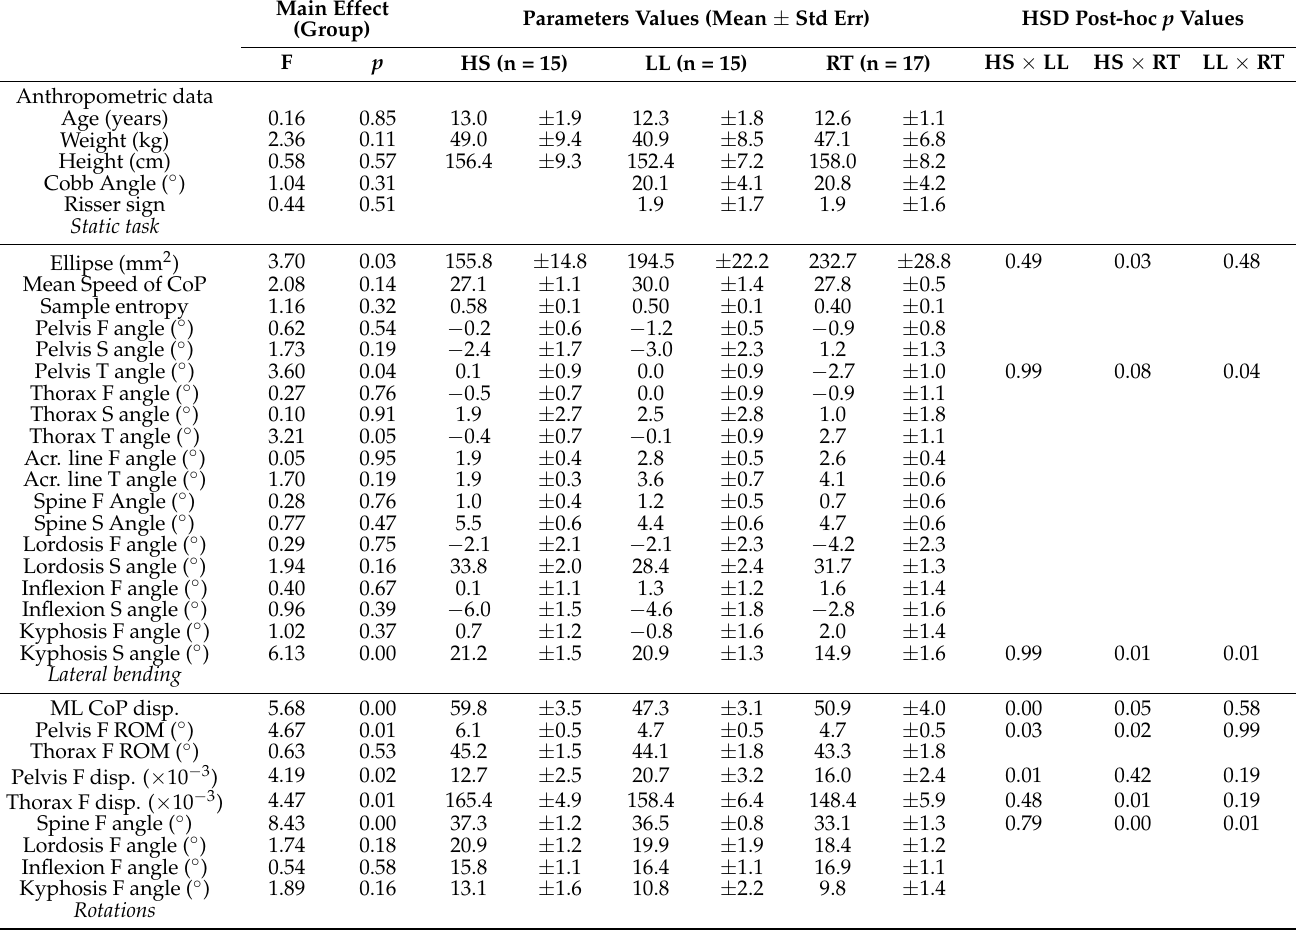
Table 1. Summary of results. In lateral bending and rotation tasks, values from right and left movements were averages since no effect of side was observed. F: Frontal, S: Sagittal, T: Transverse. Main Effect